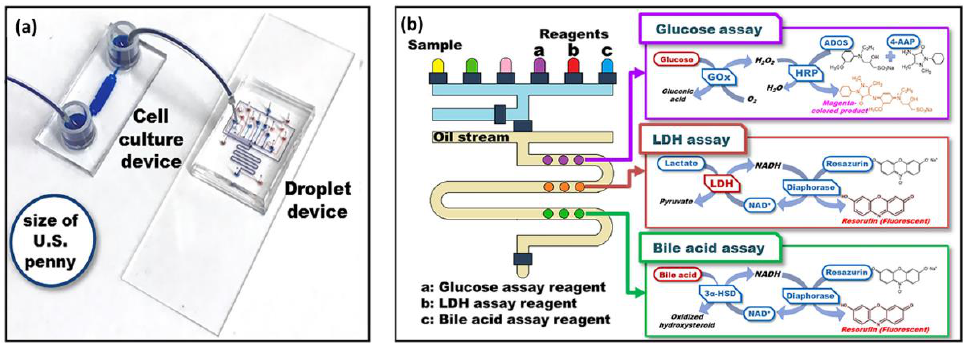
Figure 19. Droplet-based microfluidic platform for cell injury analysis. ( a ) The device was connected to a cell culturing platform for the simultaneous quantification of biochemical analytes. ( b ) Repre- sentation of the concept of achieving three different enzymatic assays. Reprinted with permission from [424]. Copyright 2019, American Chemical Society.